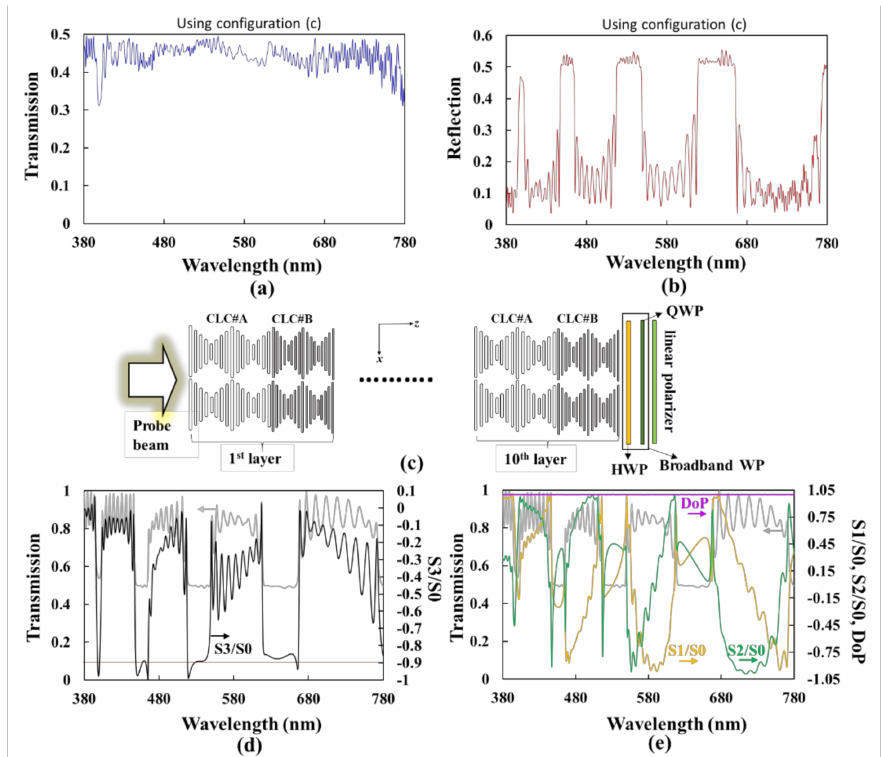
Figure 7. Simulation results of the ( a ) transmission and ( b ) reflection spectra, denoted as T( λ ) and R( λ ), respectively, in Equation (5) using the configuration of ( c ). Configuration of ( c ) is identical to that plotted in Figure 6b without the light source and reflector. ( d ) Stokes parameters of S3 / S0 (black curve) as a function of the wavelength of the light passing through the BLCPFs that are shown in Figure 6b. ( e ) Stokes parameters of S1 / S0 (orange curve), S2 / S0 (green curve), and degree of polarization (DoP) (purple curve) as functions of the wavelength of the light passing through the BLCPFs that are shown in Figure 6b. The gray curves in ( d , e ) are the same and are the simulation results of the transmission spectrum of the BLCPFs as shown in Figure